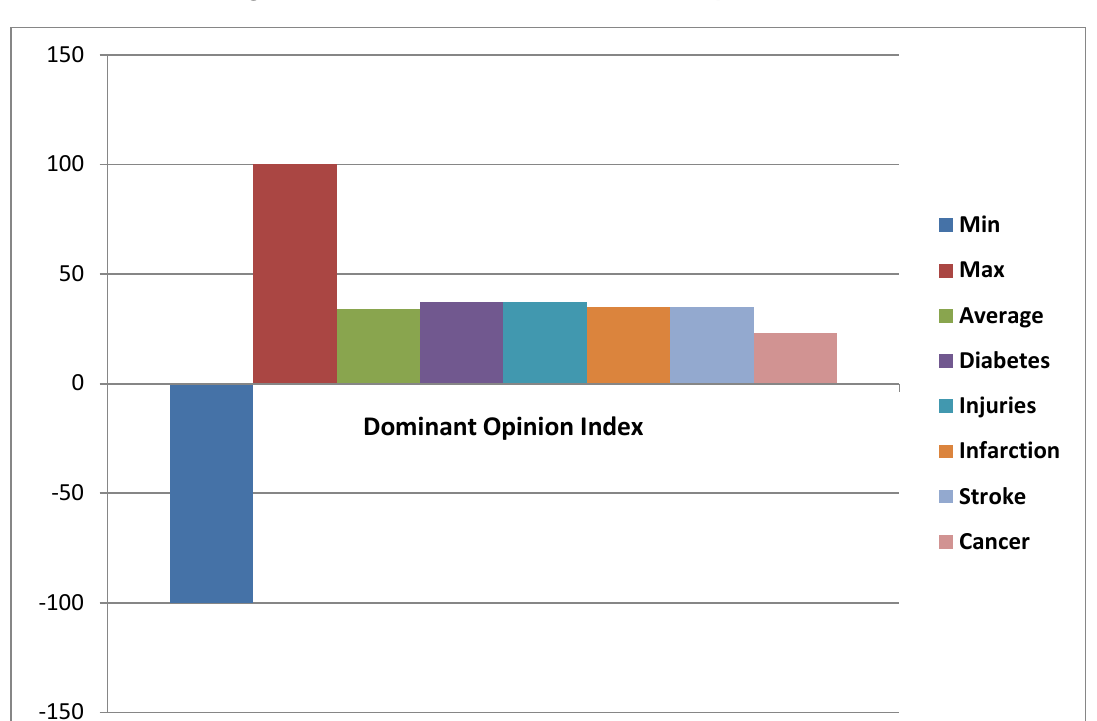
Figure 2. The value of the Dominant Opinion